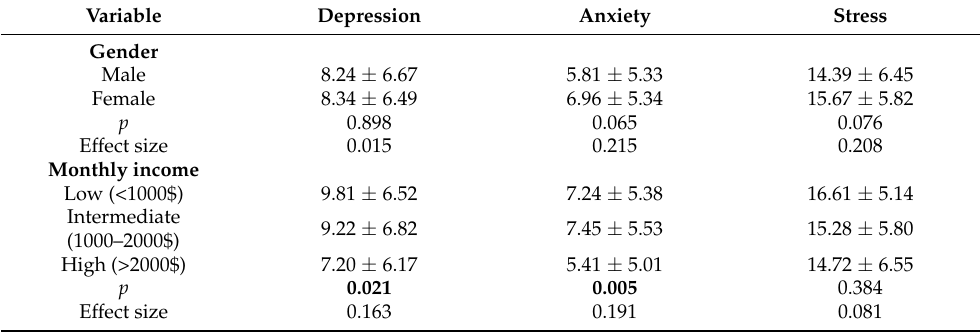
Table 2. Bivariate analysis of factors associated with the depression, anxiety and stress scores.